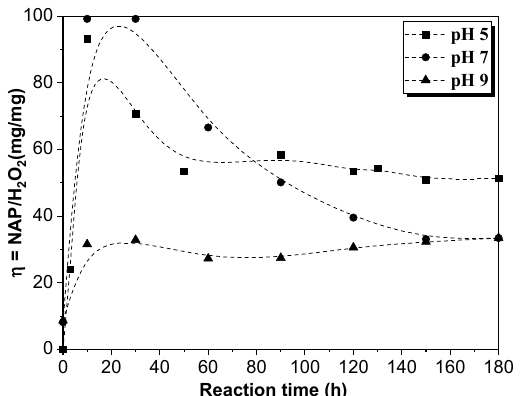
Figure 7. Effect of initial pH on the efficiency of H 2 O 2 . Reaction conditions: [NAP] 0 =10 mg/L, pH = 5, [catalyst] = 1.0 g/L, [H 2 O 2 ] 0 = 1.5 mM, T = 30 °C.